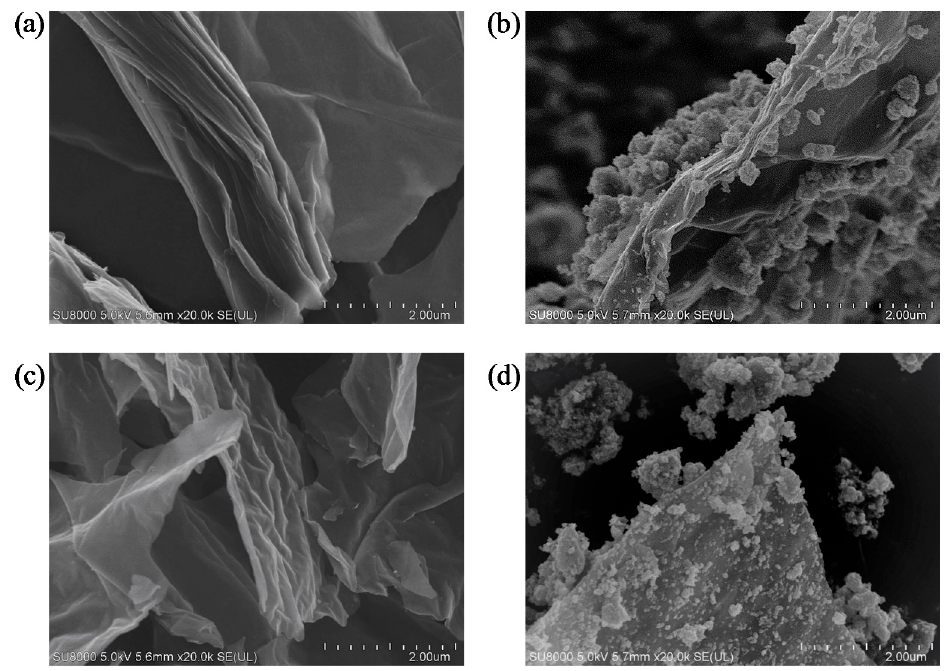
Figure 2. The SEM images of: ( a ) GO flake, ( b ) TiO 2 -GO(5 wt%)-A, ( c ) rGO flakes, and ( d ) TiO 2 -rGO(5 wt%)-A.